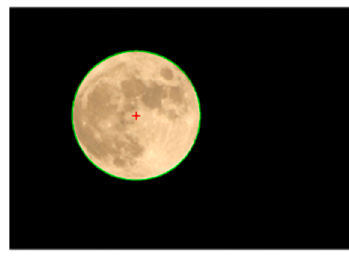
Figure 11. Moon picture (952 × 672 pixels) and circle fitting result. Red cross is the center. Table 1. Compare Circle Approximation Method with Hough Transform in moon fitting.